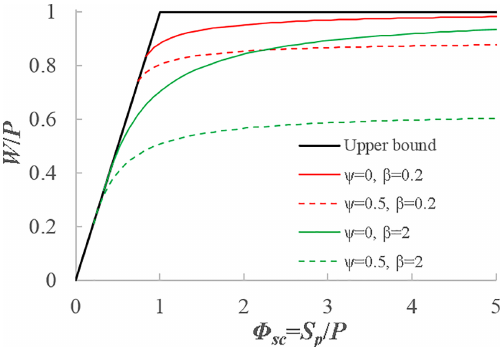
Figure 2. The impact of β and the degree of initial storage (ψ = S 0 /S b ) on the soil wetting ratio (W/P)